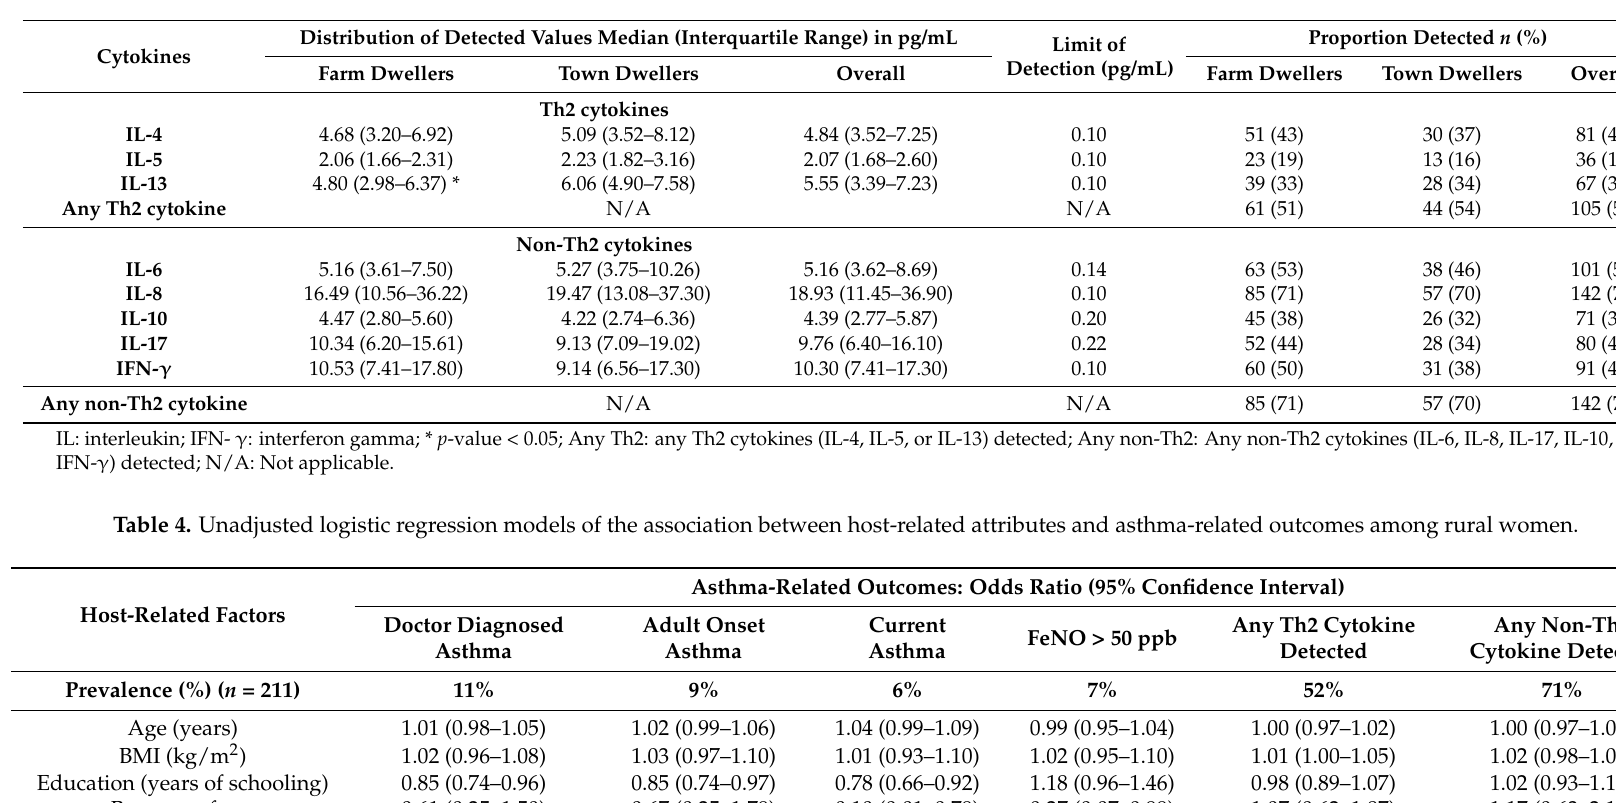
Table 3. Serum cytokine levels among rural women ( n = 201).